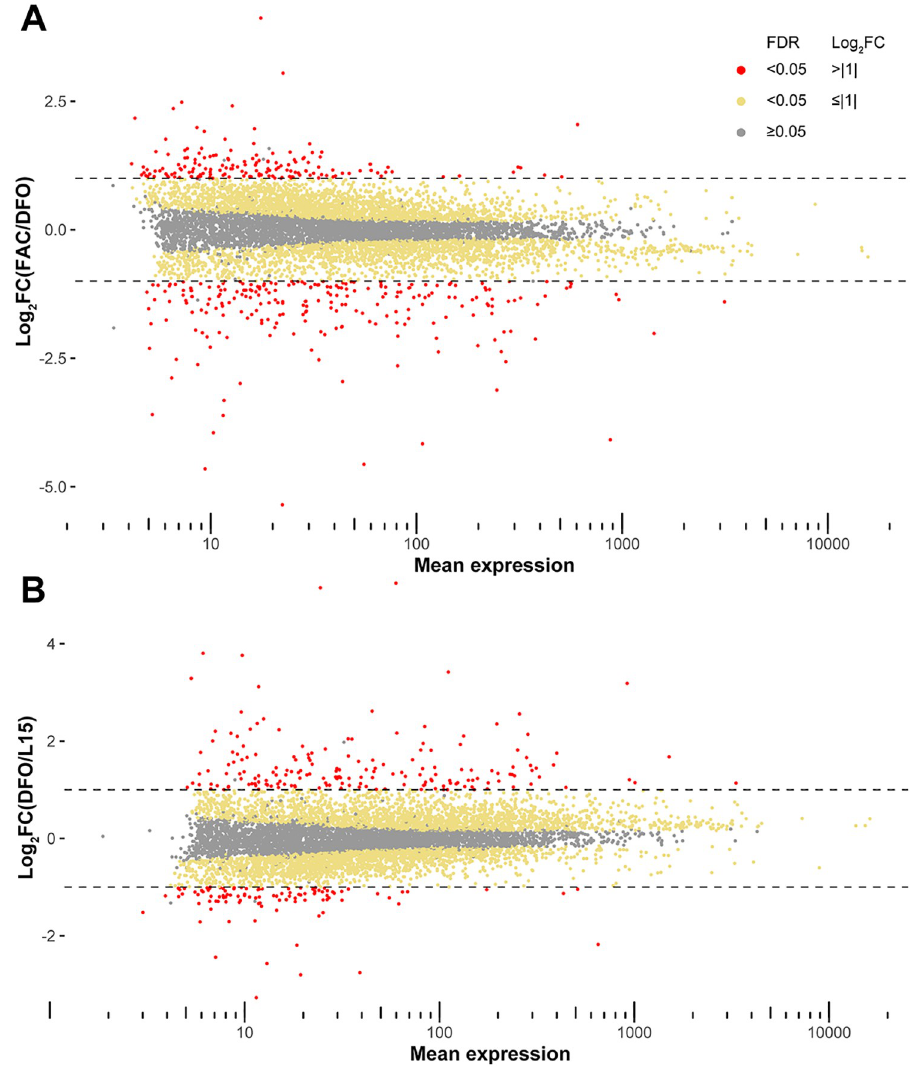
Fig 1. MA plots of expressed genes in Aag2 cells. (A) MA plot showing differentially expressed genes in Aag2 cells under FAC (100 μ M) vs DFO (50 μ M). (B) MA plot for the genes in Aag2 cells under DFO (50 μ M) vs L15. Log 2 FC: log 2 -transformed fold change values; FDR: false discovery rate; grey dots: FDR � 0.05; yellow dots: FDR < 0.05 and Log 2 FC < |1|; red dots: FDR < 0.05 and Log 2 FC � |1|. re-annotated to be non-membrane proteins and 4 genes were only found in the list of AaegL3, because one or both log FC values did not pass the criterion B) when mapped onto AaegL5 2 genome (Table 1, blue fonts). We included these genes for downstream analysis. Among these 21 genes, 2 genes are almost identical in cDNA sequences (AAEL014972 and AAEL020524), and we targeted both with one dsRNA. Based on the fold change of expression, we assigned 4 genes as candidate exporters as the depletion of iron reduced and excess iron increased their expression, while the other 17 genes were considered as potential importers as their expression pattern was the opposite. Among some of the candidate genes, we observed another Ae . aegypti cell line, A20, exhibited higher expression than Aag2 [41], and we used A20 cells for these genes for the downstream dual luciferase assay (Table 1). The original differential expression